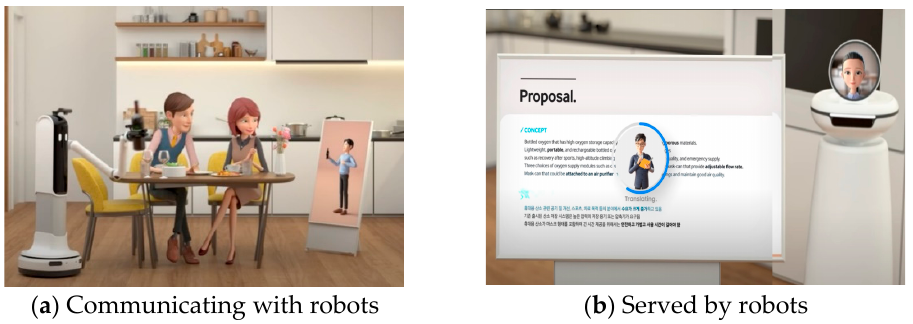
Figure 4. Scenes from the Future Home Experience from Samsung (2022). ( a ) In the scene on the left, the user communicates with an AI avatar, Bot i. ( b ) In the scene on the right, users are served by Bot Handy and consult with a digital human.